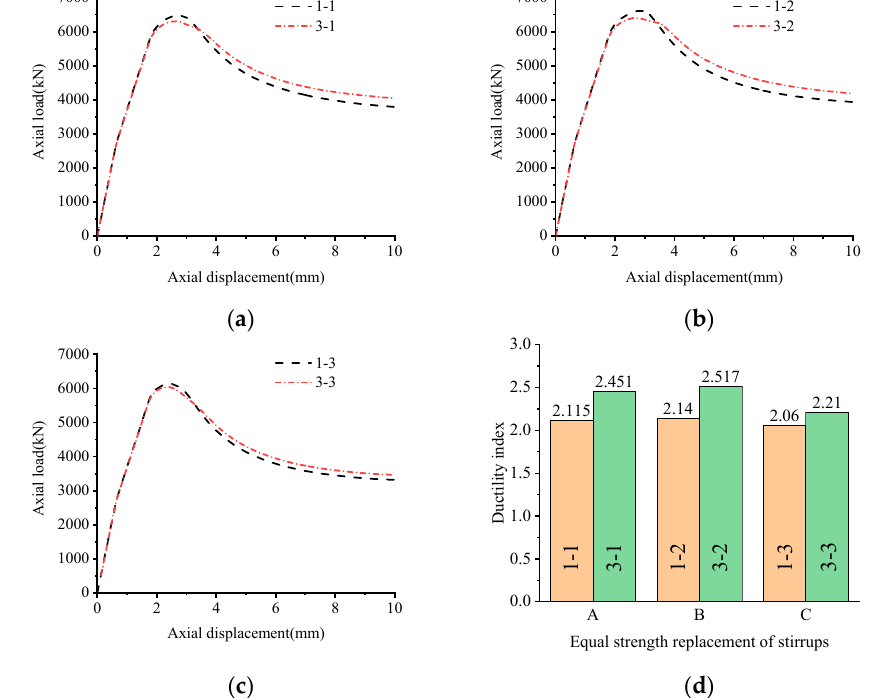
Figure 7. Effect of equal strength replacement of stirrup: ( a ) stirrup type A; ( b ) stirrup type B; ( c ) stirrup type c; ( d ) ductility index.